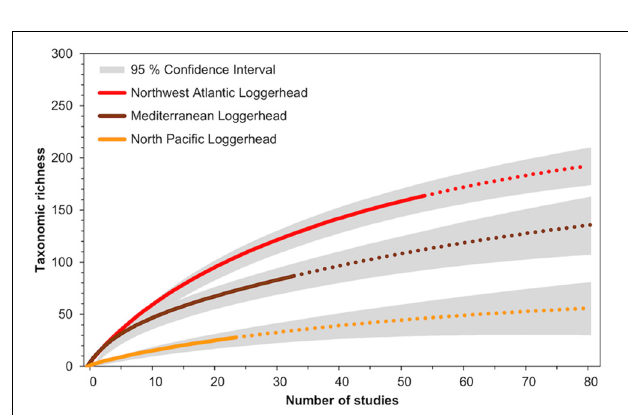
FIGURE 4 | Rarefaction curves to estimate the taxonomic richness of epibionts for three loggerhead Regional Management Units: Northwest Atlantic, Mediterranean, and North Pacific. Solid lines indicate data curves calculated from previous studies, while dashed lines represent extrapolated